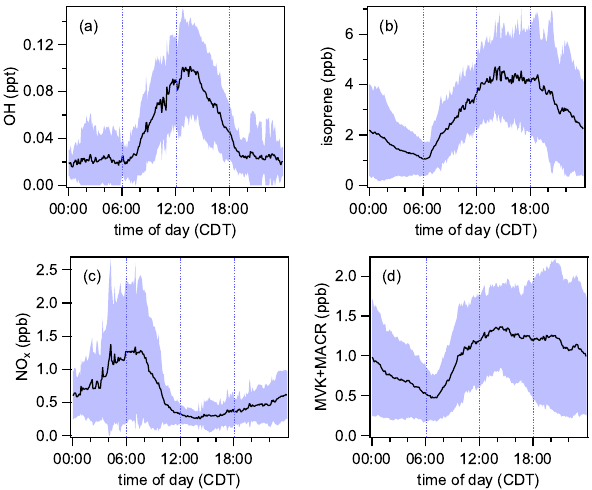
Figure 6. Diurnal average of OH ( a , 13 June–3 July), isoprene ( b